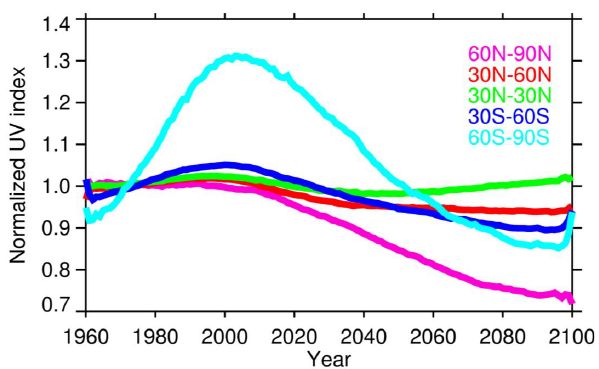
Fig. 13. Changes of erythemal weighted UV irradiances for five lat- itudinal bands 90 ◦ N–60 ◦ N (blue), 60N-30N (green), 30 ◦ N–30 ◦ S (red), 30 ◦ S–60 ◦ S (light blue) and 60 ◦ S–90 ◦ S (violet) in Septem- ber relative to the 1970–1979 average for the MPA scenario.